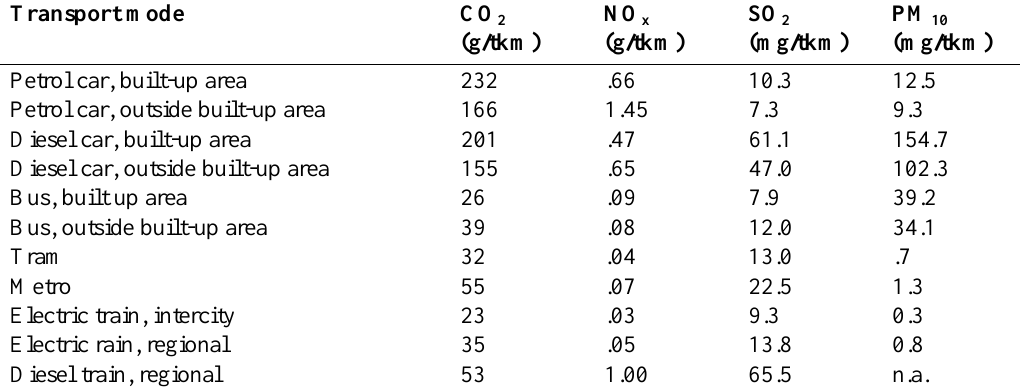
Table 4. Average emission per travellerkm for various transport modes during the peak